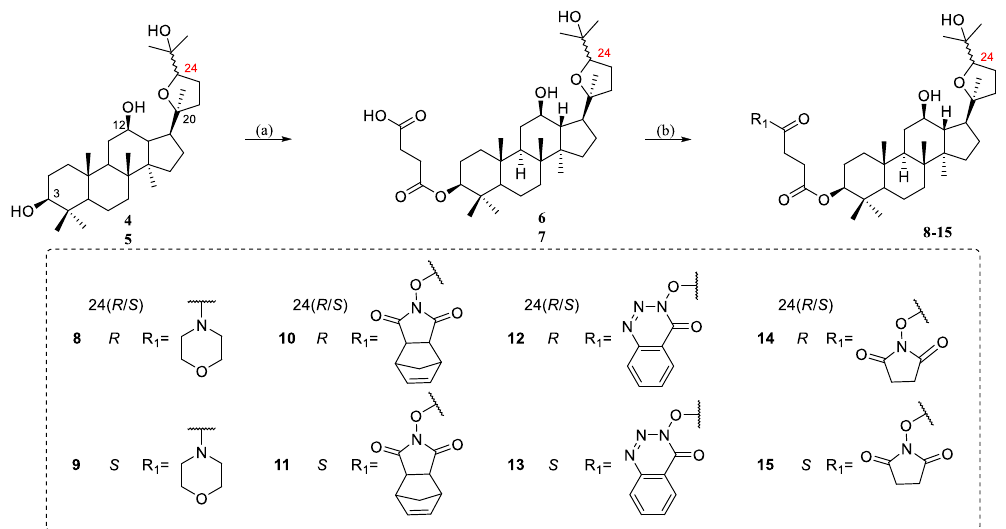
Scheme 2. Synthetic route of ocotillol-type compounds 8 – 15 . Reagents and conditions: (a)